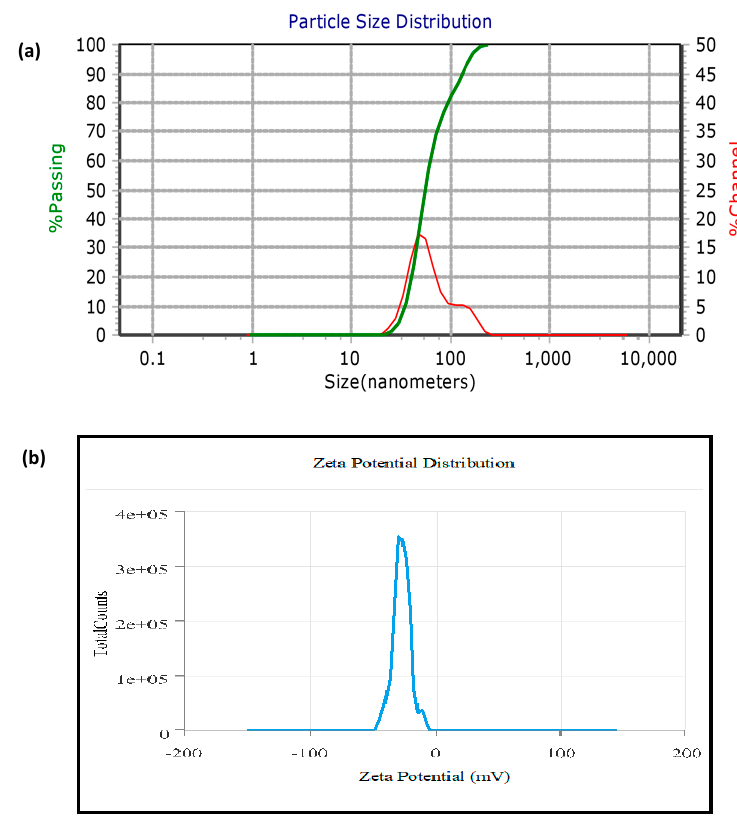
Figure 3. ( a ) PSA of biosynthesized AgNPs; ( b ) Zeta potential of AgNPs.